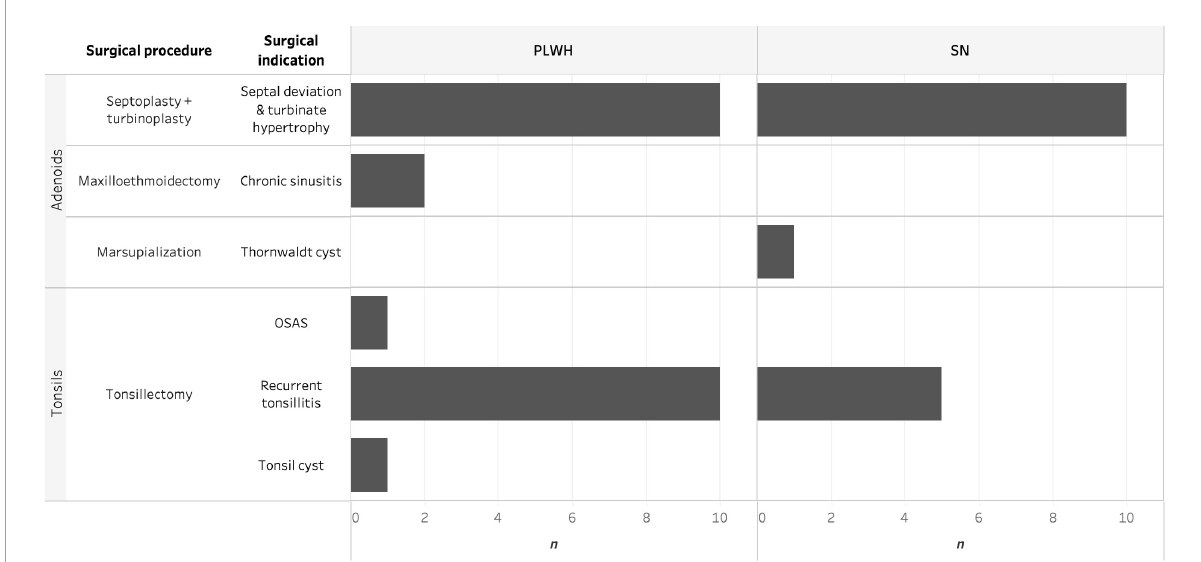
FIGURE1 Histogram depicting the surgical procedure and surgical indication for adenoidectomy and tonsillectomy faceted by HIV status and anatomical site. HIV, human immunodeficiency virus; OSAS, obstructive sleep apnea syndrome; PLWH, people living with HIV; and SN, seronegative.